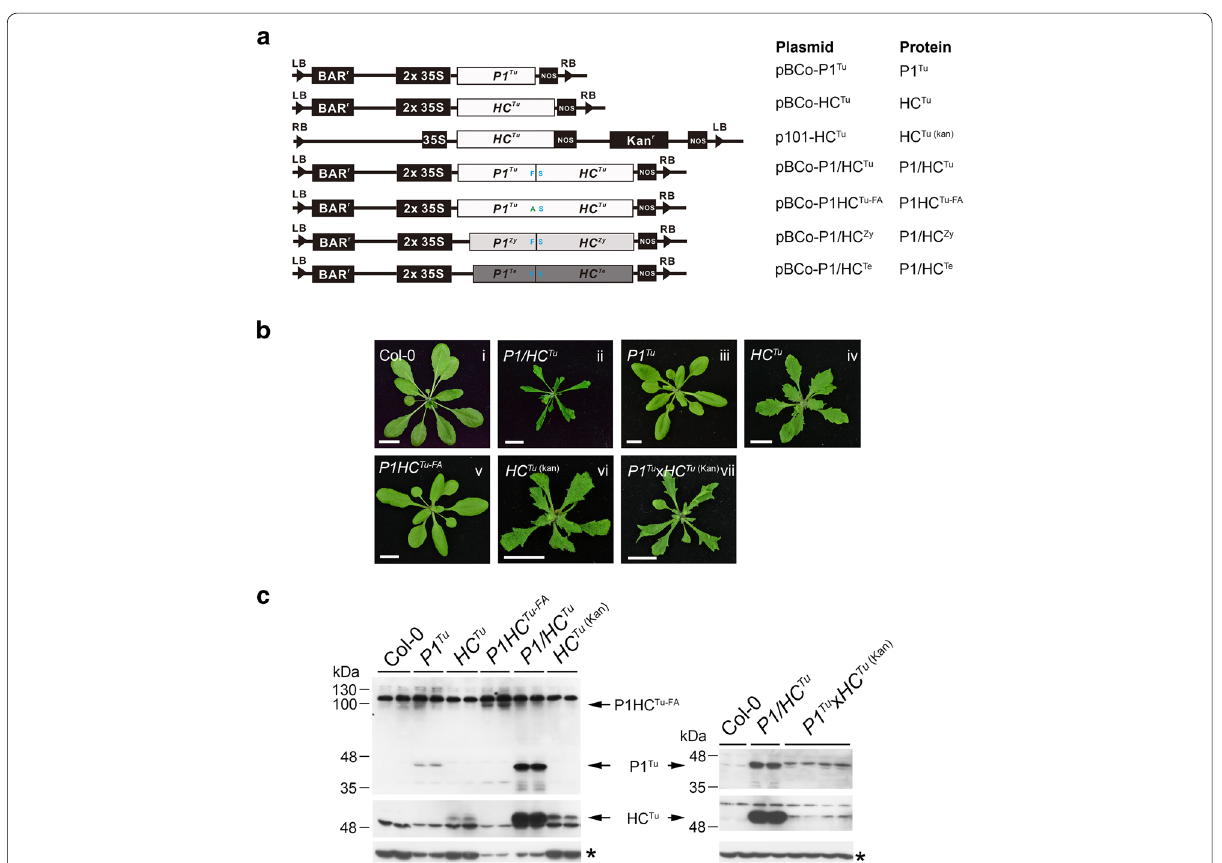
Fig. 1 P1 enhances the HC Tu ‑mediated phenotype and HC Tu suppression in miRNA‑mediated regulation. a Schematic binary plasmids containing the various constructs that were used in this study. b Phenotypes of the different transgenic plants. The photographs were taken of 3‑week‑old seedlings. Bar, 1 cm. c Detection of P1 and HC‑Pro of TuMV in various transgenic plants by western blotting. The asterisk (tubulin) is an